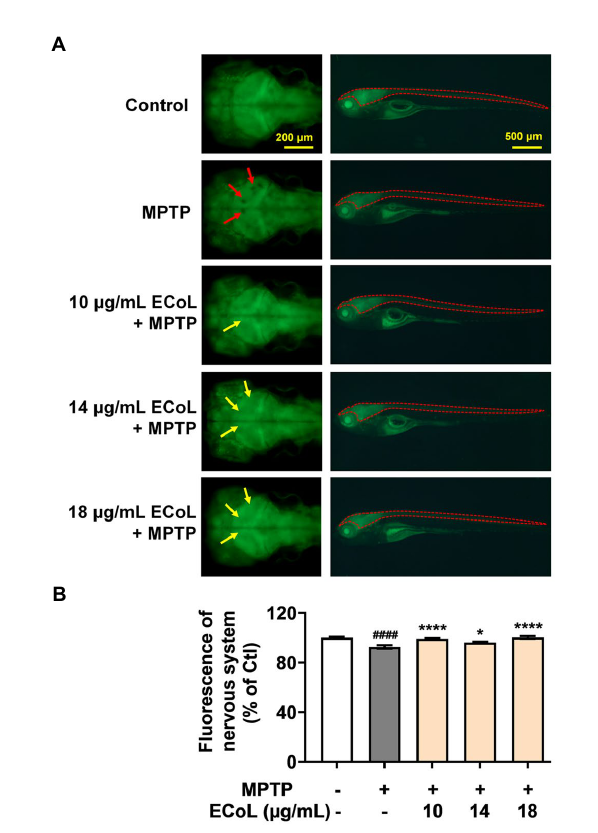
FIGURE 3 Effect of ECoL on MPTP-induced nervous system injury. (A) Representative fluorescent microscopy images of elavl3:EGFP zebrafish in Control, MPTP, and ECoL+ MPTP co-treatment groups. The left column is the dorsal view of fluorescence-labeled nervous system in zebrafish brain. Scale bar, 200 μ m. The right column is the lateral view of fluorescence-labeled nervous system in zebrafish body. Scale bar, 500 μ m. The fluorescence loss in nervous system is indicated by the red arrows. ECoL co-treatment protect the injured nervous system induced by MPTP as indicated by yellow arrows. (B) Statistical analysis of the fluorescence of nervous system (indicated by the red dotted line in the lateral view of zebrafish in A) in each group, n = 8. #### p < 0.0001 vs. Control; * p < 0.05, **** p < 0.0001 vs.